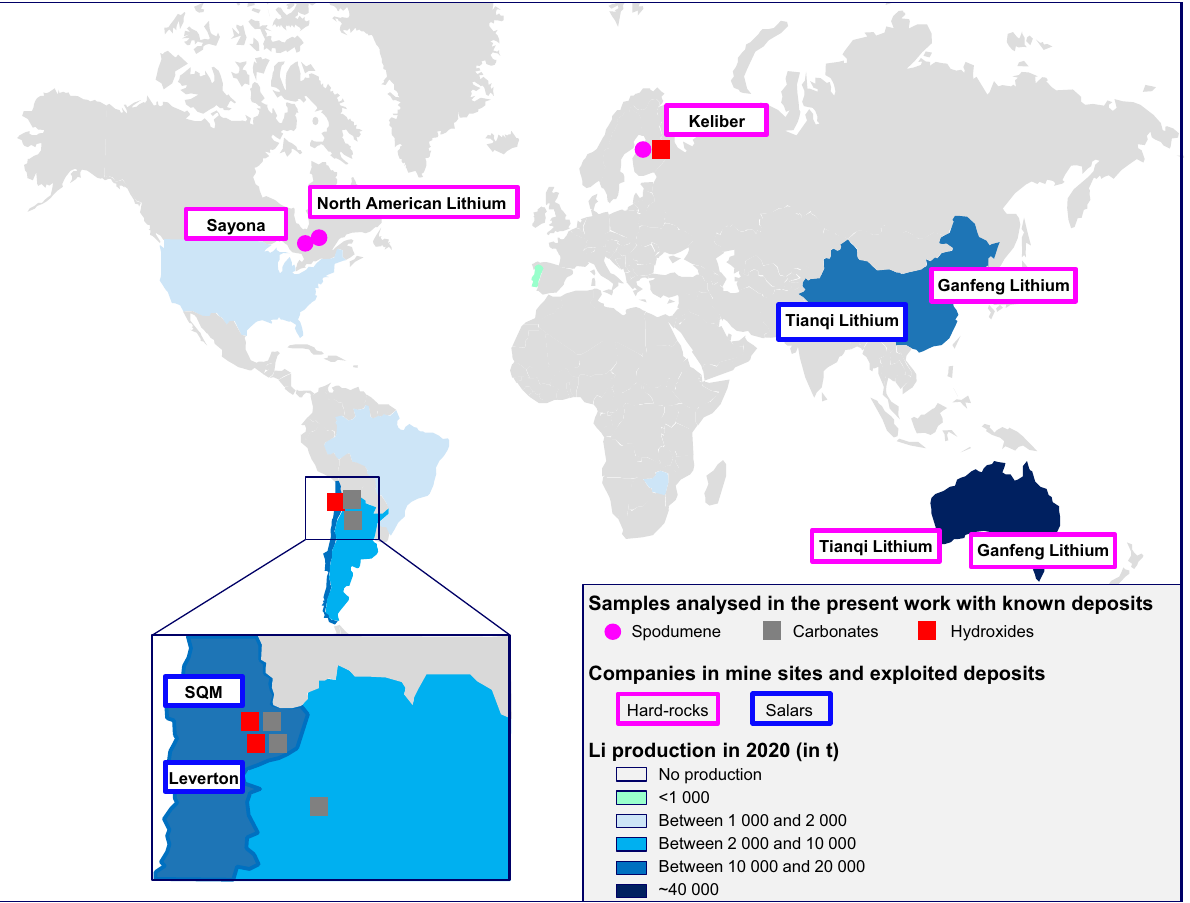
Fig. 1 Map of world Li production in 2020 and location of lithium mining and re fi ning companies studied in this work. World mine production in 2020 is from USGS (2021) 10 data, except for the United States for which the value represented is the 2018 production 16 data. Spodumene concentrates, lithium hydroxides and carbonates analysed in this study with known deposits are shown, as is the lithium carbonate produced by Alfa Aeser in